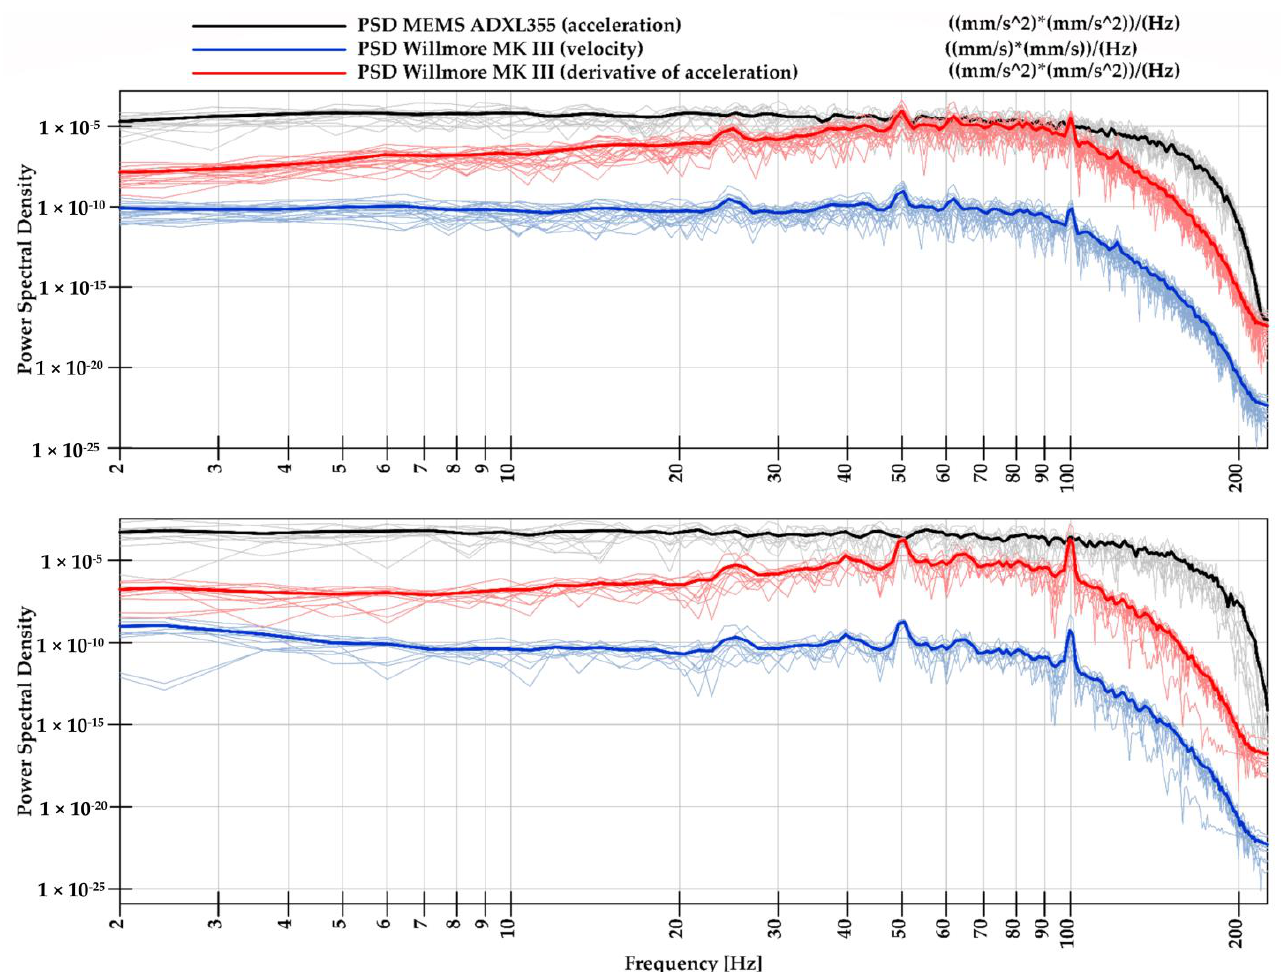
Figure 6. The PSD of noise recorded by Willmore MK III seismometer and ADXL355 MEMS accelerometer in horizontal ( top ) and vertical ( bottom ) direction.